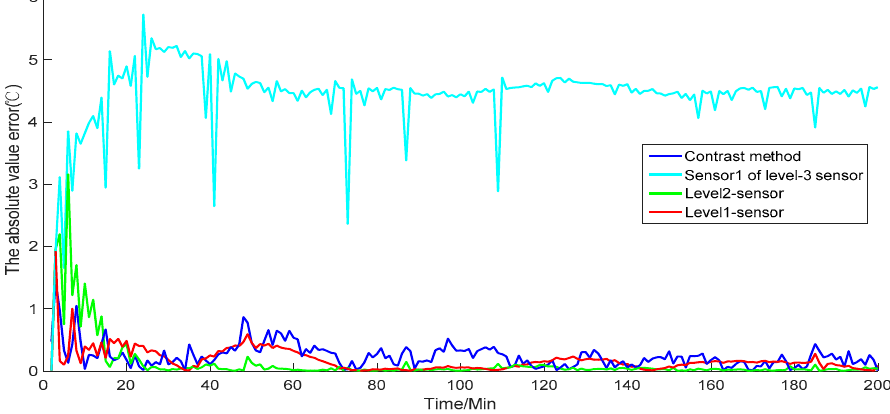
Figure 13. Absolute error of sensor one, level-two sensors, and level-one sensors, and the contrast method.